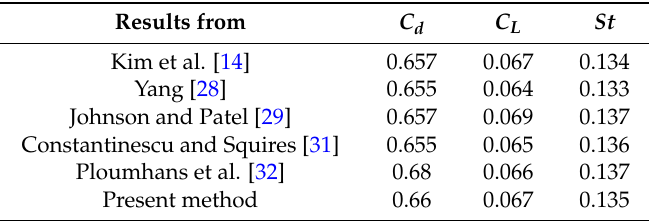
Table 3. Numerical results for flow past over a sphere at Re =